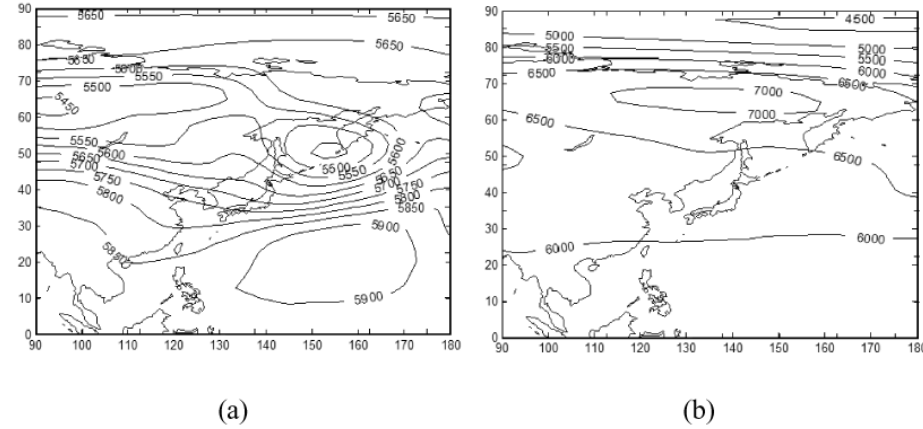
Fig. 3. (a) The potential field of the stable equilibrium and (b) the potential field of the unstable equilibrium of 2006.